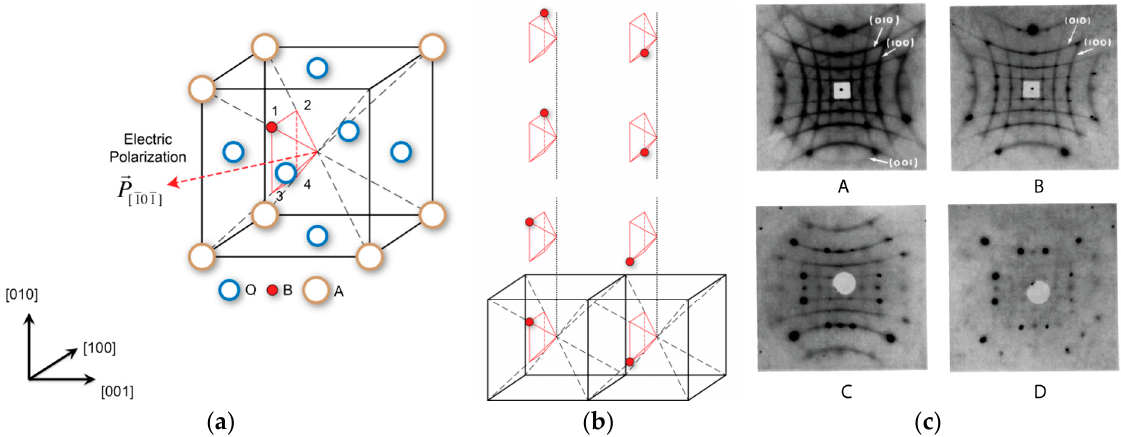
Figure 4. ( a ) The degenerate B atomic displacement in ABO 3 oxides is illustrated with particular reference to the orthorhombic phase of KNbO 3 . The displacements along the possible <111> directions are marked by indices 1–4. ( b ) The B atomic displacements are correlated over short-range in the form of 1-dimensional chains. ( c ) The 1-dimensional chains give rise to {100} diffuse scattering sheets, which are observed as straight lines on an area detector. The scattering patterns measured with laboratory X-rays and an area detector are shown for cubic (A), tetragonal (B), orthorhombic (C), and rhombohedral (D) phases of a KNbO 3 crystal, after Comes et al. [54,55] Reproduced with permission from the International Union of Crystallography, https://journals.iucr.org/